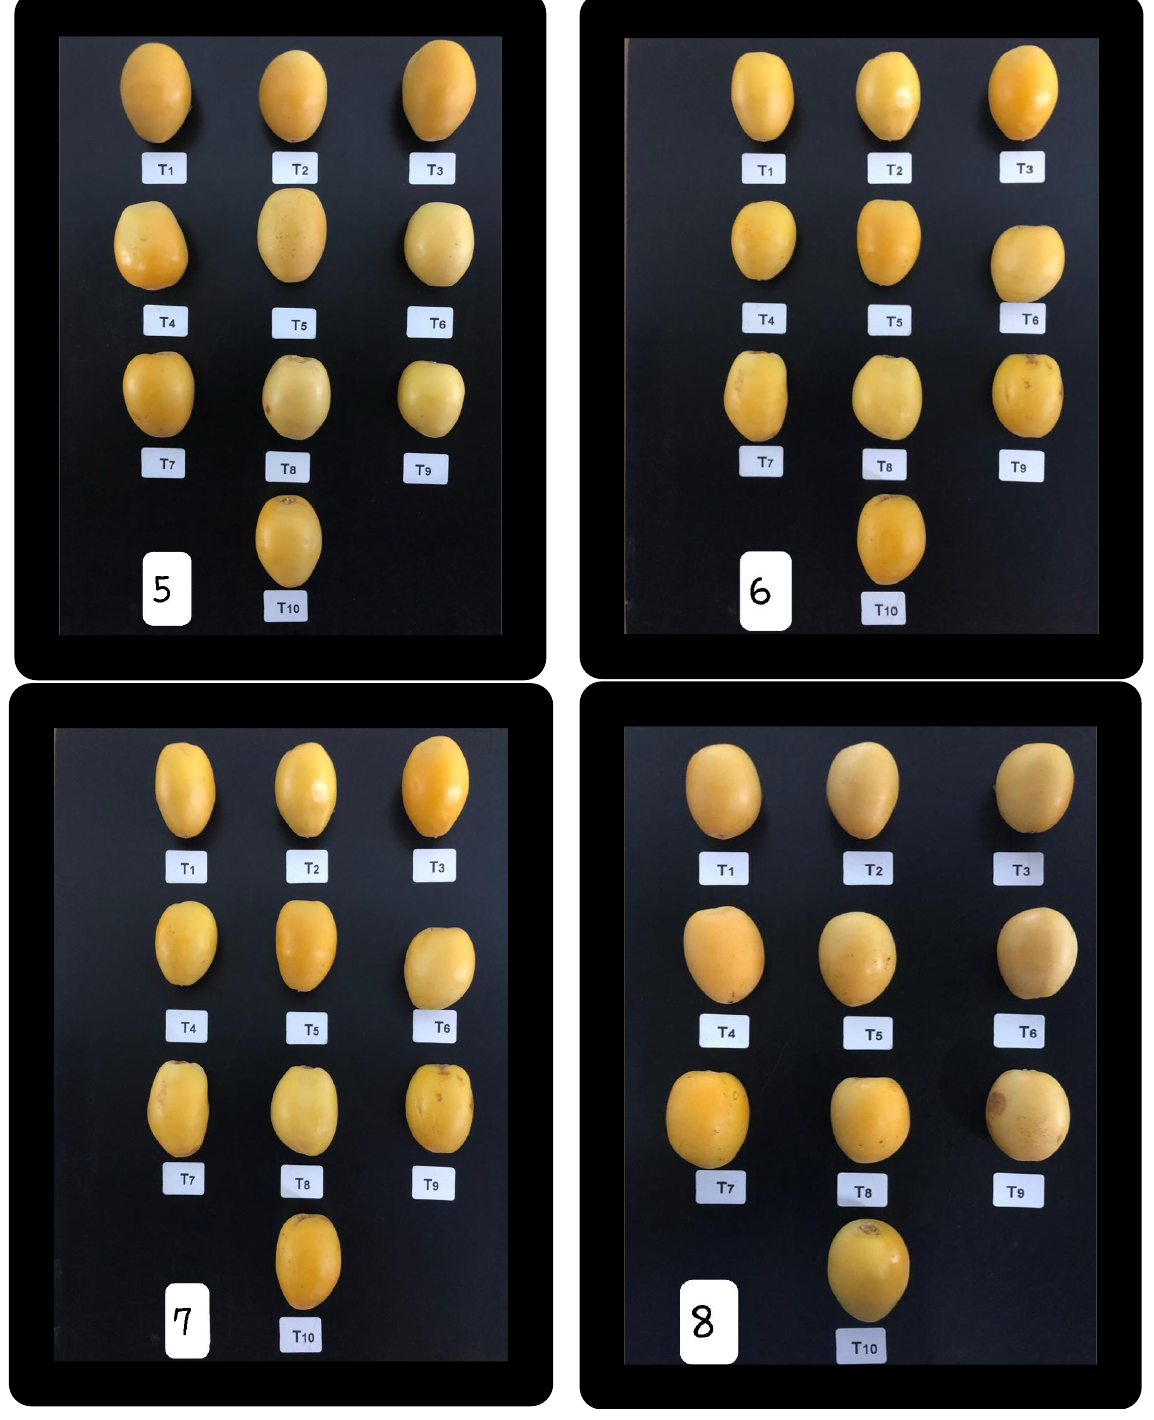
Figure 3. Barhi date palm fruits were cold stored for 70 days divided to 8 intervals (0, 10, 20, 30, 40, 50, 60, and 70 days) after some pre-harvest treatments were applied via foliar spray.